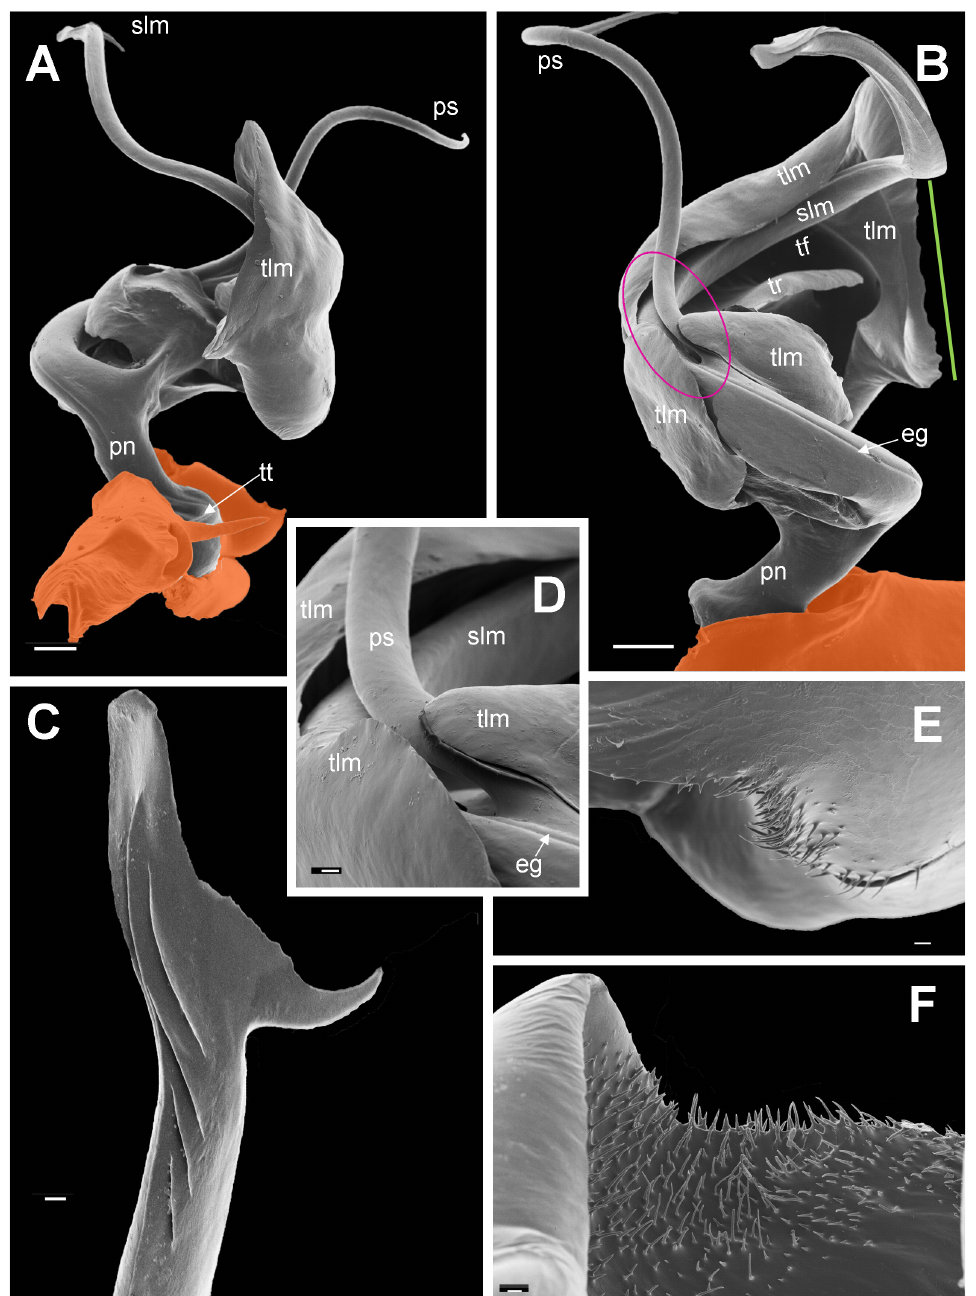
Fig. 4. Casuariverpa scarpa gen. et sp. nov. , paratype from Udzungwa Scarp Forest Reserve above Chita village, left gonopod telopodite. A . Apical view, coxal parts in orange colour. B . Basal view, purple oval roughly corresponds to Fig. 4D, coxal parts in orange colour, the green line indicates the distal margin of the telomere. C .Tip of solenomere. D . Origin of proximal solenomeral spine ( ps ) between two basal lobe of telomere ( tlm ), image roughly corresponding to purple oval on Fig. 4B. E . Micro-spinose field on basal external side of telomere basis, image roughly corresponding to area in yellow circle on Fig. 3G. F . Micro-spinose field on distal part of telomere concavity, image roughly corresponding to area in red oval on Fig. 3H. Abbreviations: eg = efferent groove, pn = post-torsal narrowing, ps = proximal solenomeral spine, slm = solenomere, tf = telomeral furrow, tlm = telomere, tr = telomeral ridge tt = torsotope. Scales: A–B = 0.1 mm; C–F = 0.01